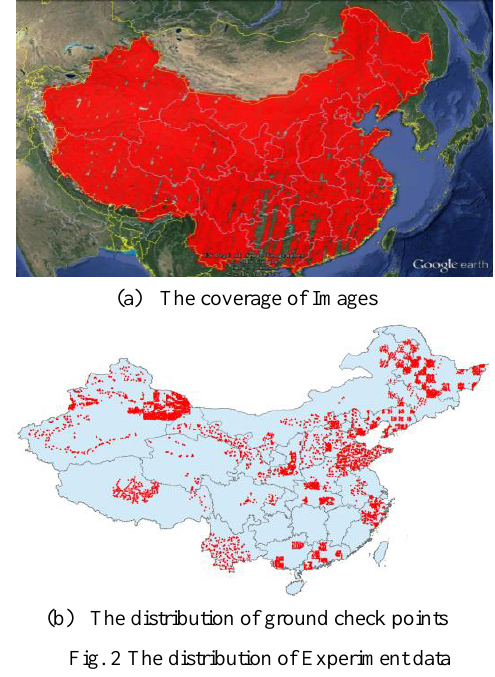
Fig. 2 The distribution of Experiment